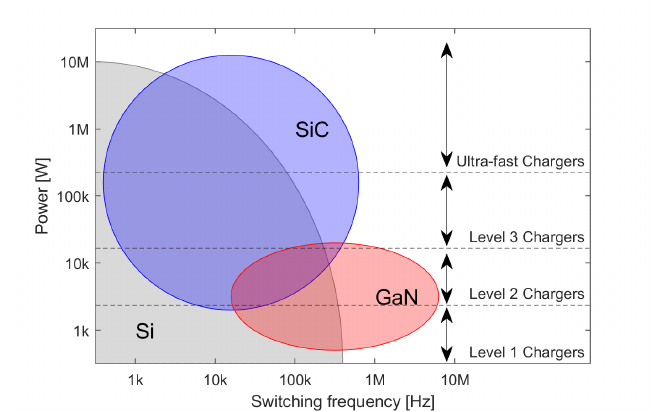
Figure 20. Application of power semiconductors by